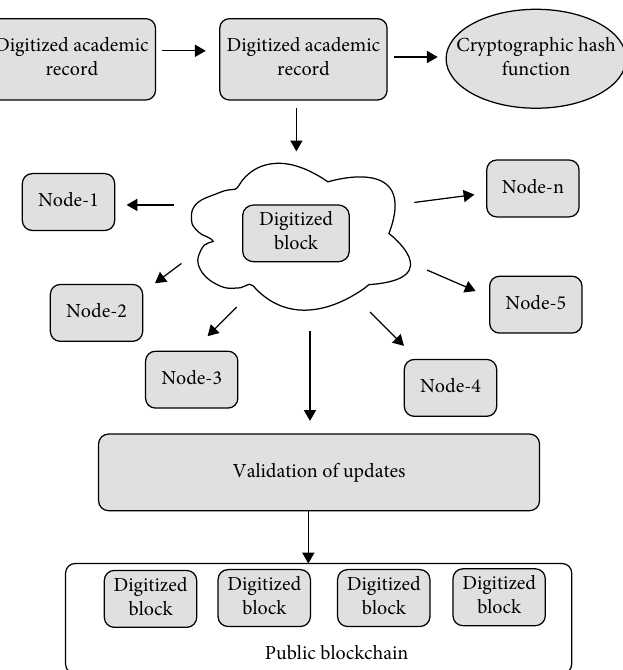
Figure 7: A blockchain-based conceptual framework for augmenting security of digitized academic records.